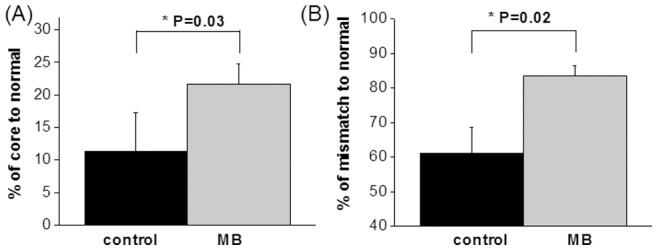
Percentage of survived core (C) and mismatch (D) tissues of control and MB-treated groups.